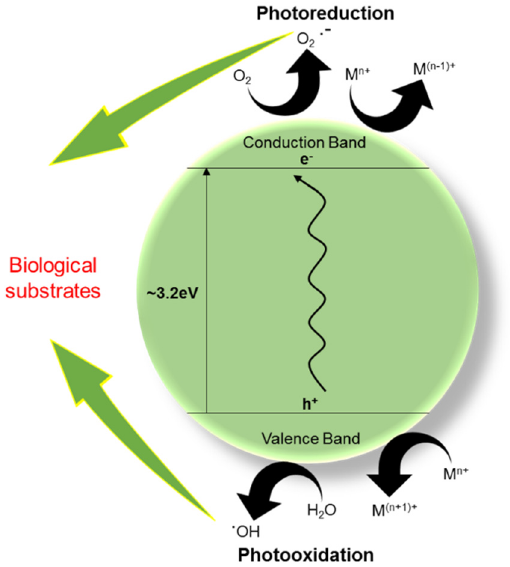
Figure 2. The semiconducting and photocatalytic properties of TiO 2 NPs.